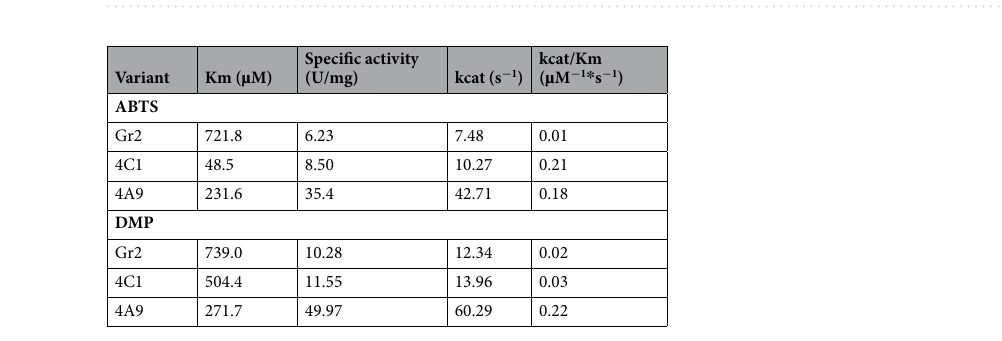
Figure 6. Laccase expression with evolved alpha factors in 96-well plates (green) and in shaking flasks (grey). The highest activity in each experiment was set to 100%.